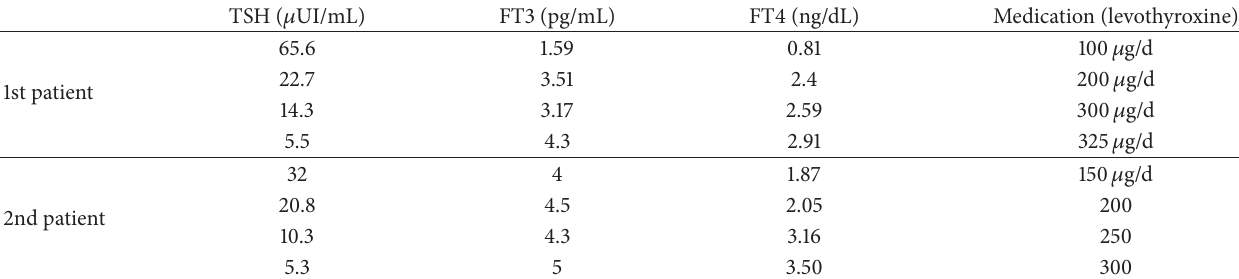
Table 2: TSH, FT3, and FT4 levels and levothyroxine therapy in both patients, after thyroidectomy. TSH ( 𝜇 UI/mL) FT3 (pg/mL) FT4 (ng/dL) Medication